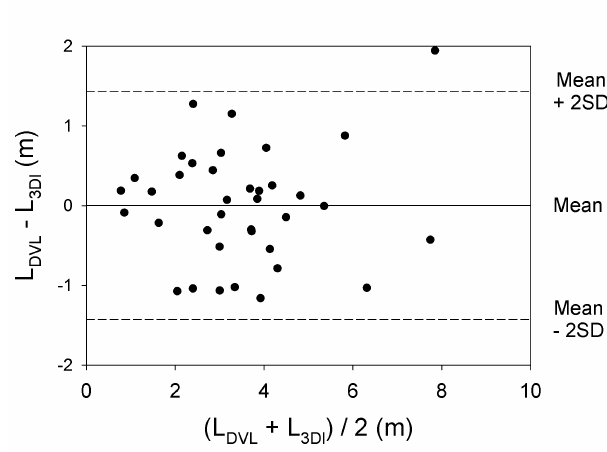
Fig. 8. Bland and Altman plot of difference against mean for the subtransect lengths measured from 3-D models ( L 3Dl ) and from underwater navigation ( L USBL ).